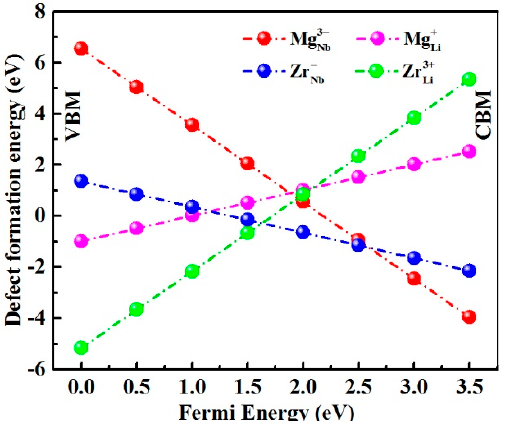
Figure 3. Formation energies of point defects Mg Li+ , Mg Nb3– , Zr Li3+ , Zr Nb– in LN:Mg,Zr crystals. The valance-band maximum and the conduction-band minimum are labelled as VBM and CBM, respectively. Fermi energy (E F ) range corresponds to the fundamental band gap of LN. Table 1. Formation energies of defect clusters in LN:Mg,Zr.